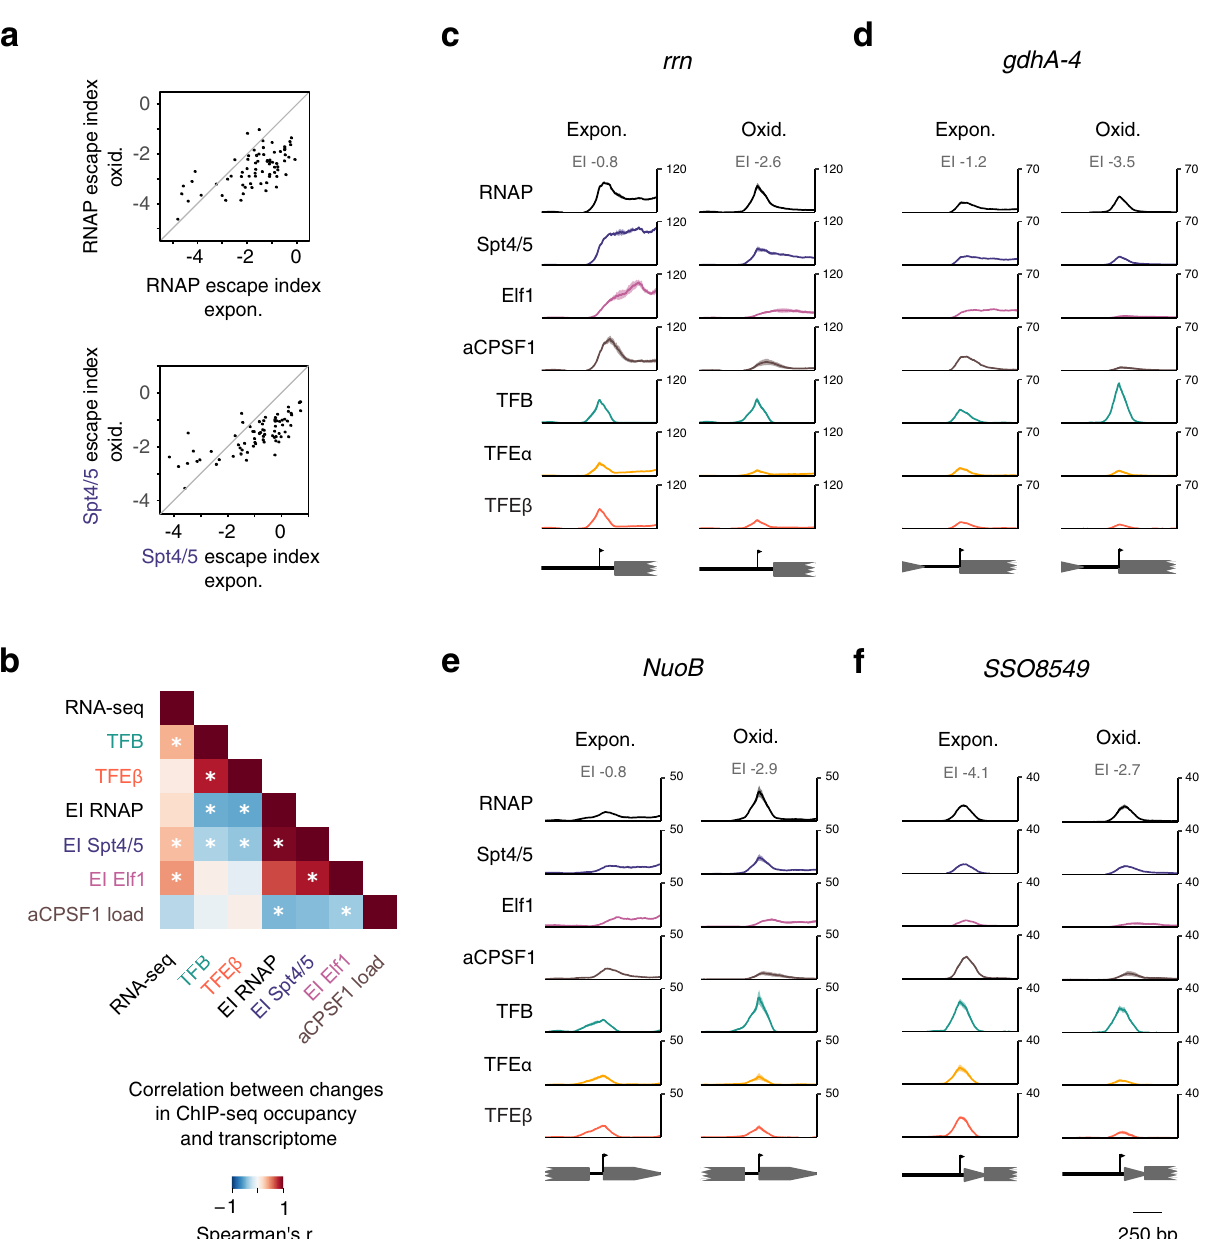
Fig. 5 TEC escape changes during oxidative stress response. a High escape TUs show reduced TEC escape under oxidative stress. Scatter plots comparing escape indices under exponential growth and oxidative stress conditions for 71 TUs accessible for analysis in both conditions. b Heatmap showing correlated changes in initiation factor occupancy, escape indices and RNA output between exponential growth and oxidative stress. Spearman rank correlations were calculated for protein-encoding TUs accessible for analysis in both conditions ( n = 70). Correlations were calculated for the mean escape index and the geometric mean of all other values for two biological replicates. * denotes an adjusted p -value < 0.05 after multiple testing correction (Benjamini – Hochberg) and p < 0.05 for two combinations of individual biological replicates tested. c – f ChIP-seq pro fi les of the basal transcription machinery for four different promoters during exponential growth (Expon.), and oxidative stress (Oxid.): rrn ( c ), gdhA-4 ( d ), NuoB ( e ), and SSO8549 ( f ). Traces show mean occupancy for two biological replicates with the range depicted as semi-transparent